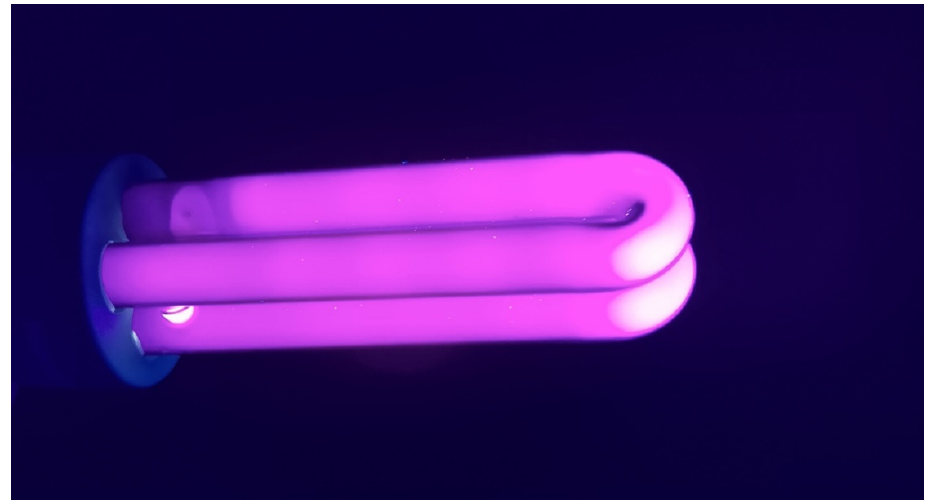
Figure 1. Compact fluorescent blacklight bulb. Author’s photo.